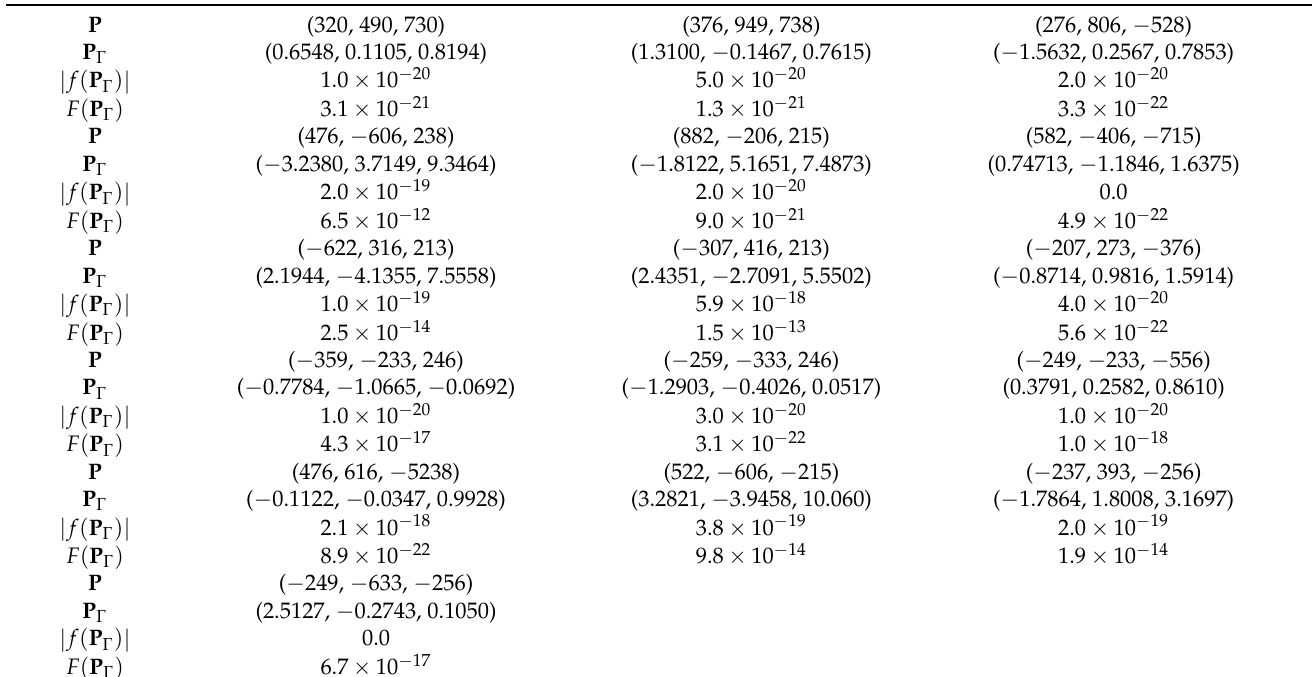
Table 1. The obtained running results of Algorithm 4 through Example